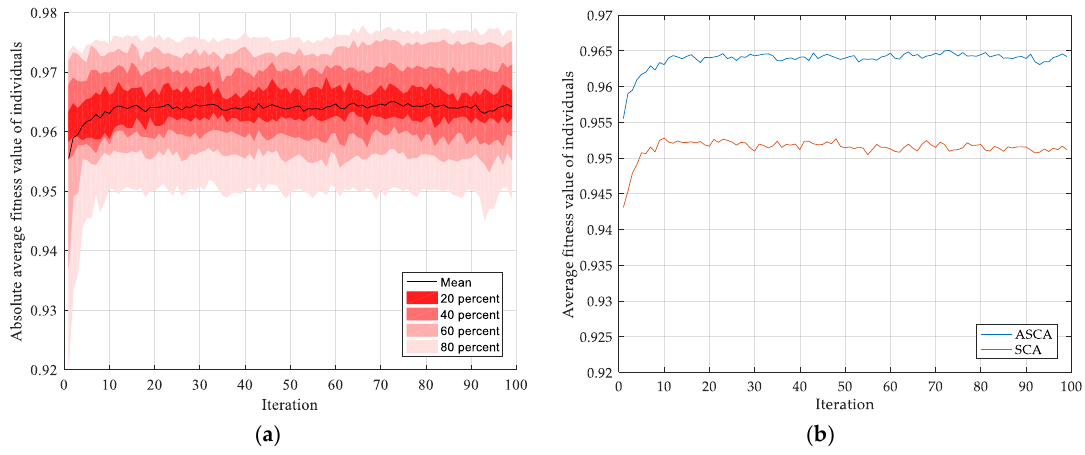
Figure 9. Convergence procedure of adaptive parameter optimization (0.5 labeled): ( a ) Distribution of convergence curves in 10 runs, ( b ) comparison of different optimization methods.